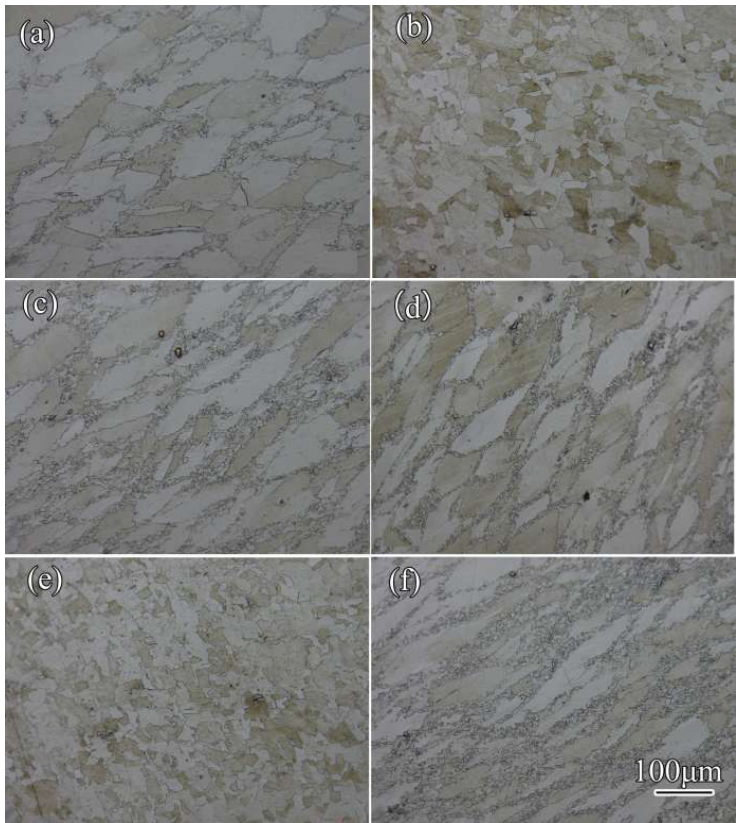
Figure 6. Microstructures of GH4169 compressed at ( a ) 1000 °C, 0.1 s −1 , 0.4; ( b ) 1050 °C, 1 s −1 , 0.5; ( c ) 1000 °C, 0.1 s −1 , 0.5; ( d ) 1080 °C, 0.001 s −1 , 0.5; ( e ) 950 °C, 1 s −1 , 0.6; and ( f ) 1000 °C, 0.1 s −1 , 0.6. The processing conditions corresponded to the pink dots numbered 1~6 # in Figure 5.